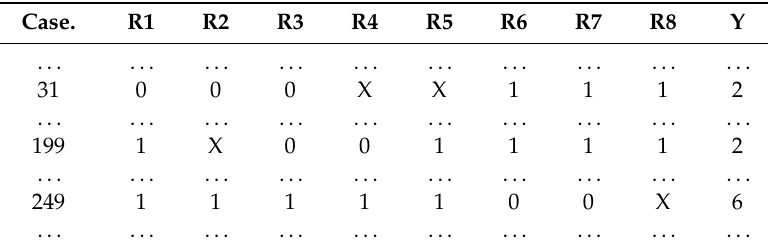
Table 4. Simplified Rule Base for DSP and